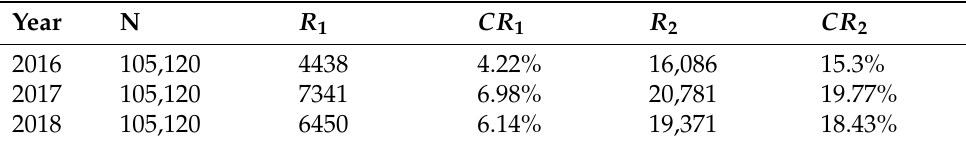
Table 3. Impact of asynchronous optimization algorithm on the 3-year NREL